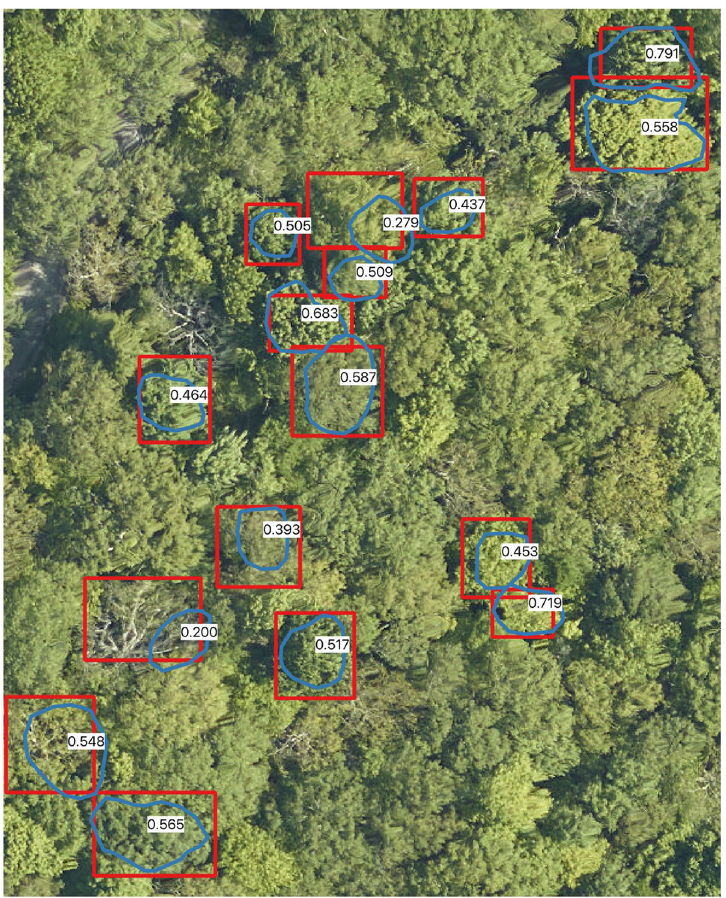
Fig 8. Comparison of field-annotated crowns made by one author (SG) in blue (n = 16) and image-annotated crowns made by another author (BW) in red at Mountain Lake Biological Station, Virginia. Intersection-over- union scores are shown in white. Only the image-annotated crowns associated with the field crowns are shown (out of the 206 image-annotated crowns in this image). From this and similar visualizations we determined that a threshold of 0.4 was a reasonable choice for eliminating crowns that are not sufficiently overlapping to be used for ecological